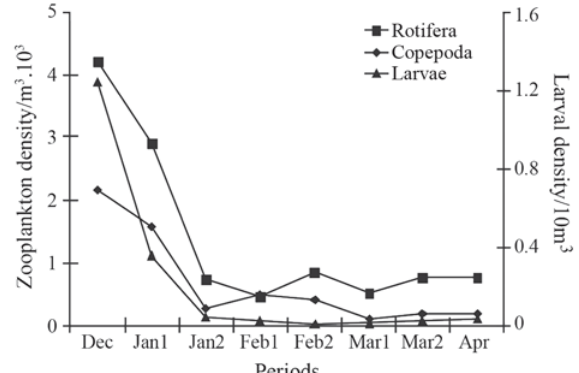
Fig. 8. Mean fish larvae density as a function of Rotifera and Copepoda density in marginal lagoons along the Cuiabá River between December 2006 and April